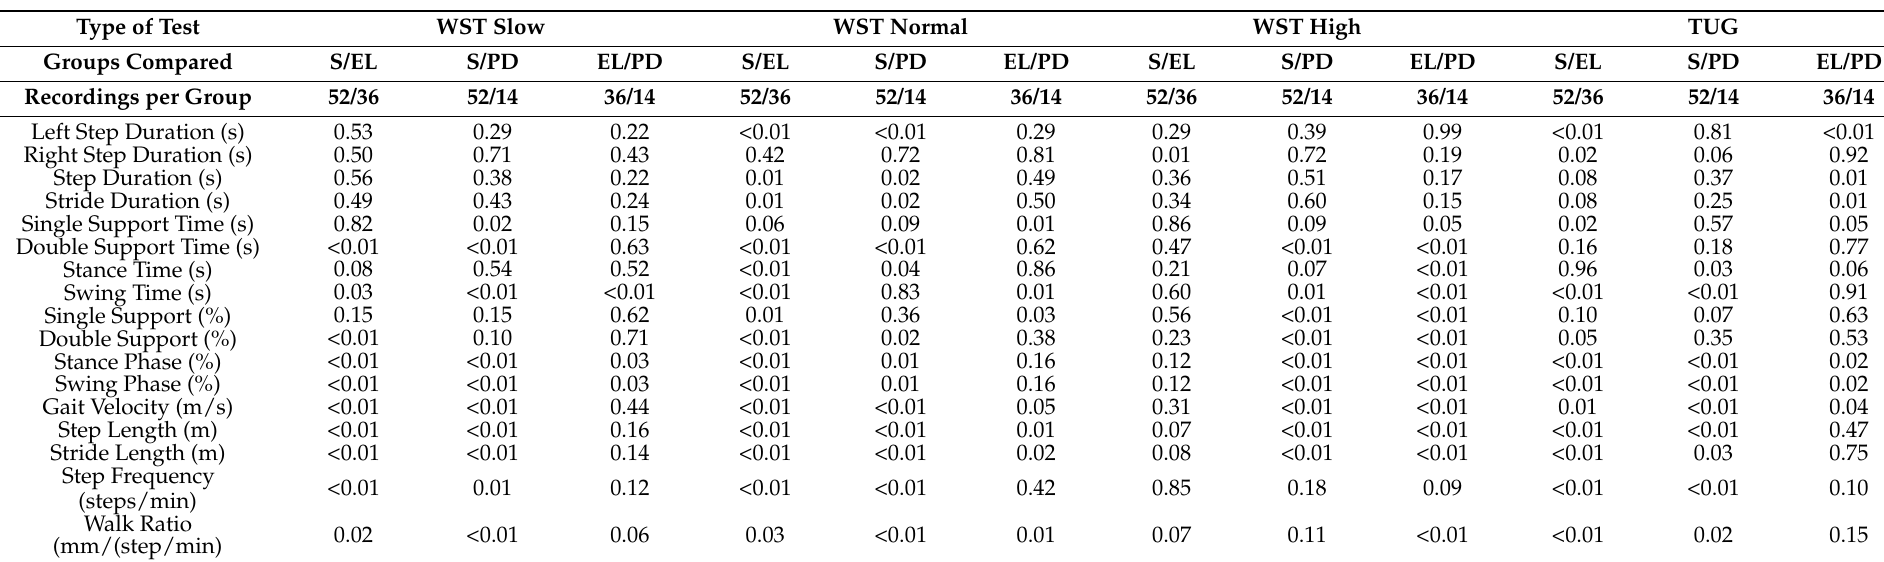
Table 8. p -values of the estimated results for Straight Lines with statistically significant p < 0.01 for three combinations of participants’ groups (S/EL, S/PD, EL/PD) and for each different test. Type of Test WST Slow TUG Groups Compared S/EL Recordings per